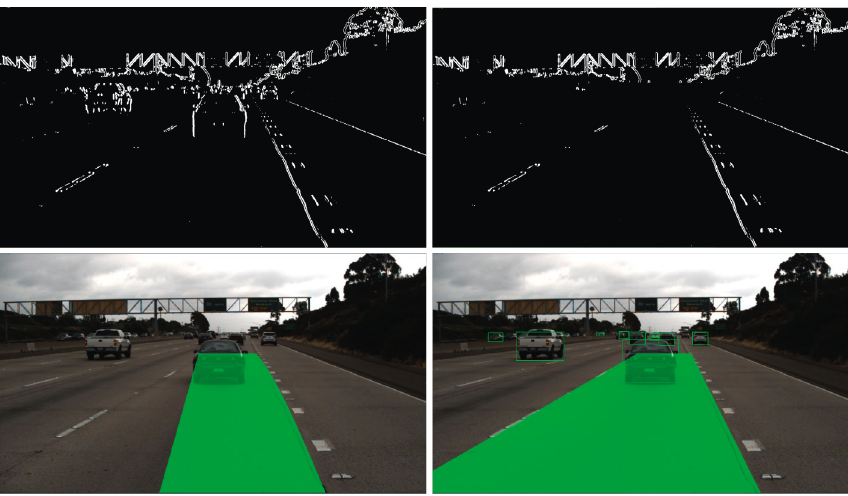
Figure 17: Using obstacle detection results to improve lane detection algorithms. Table 2: The parameters of the simulation system.